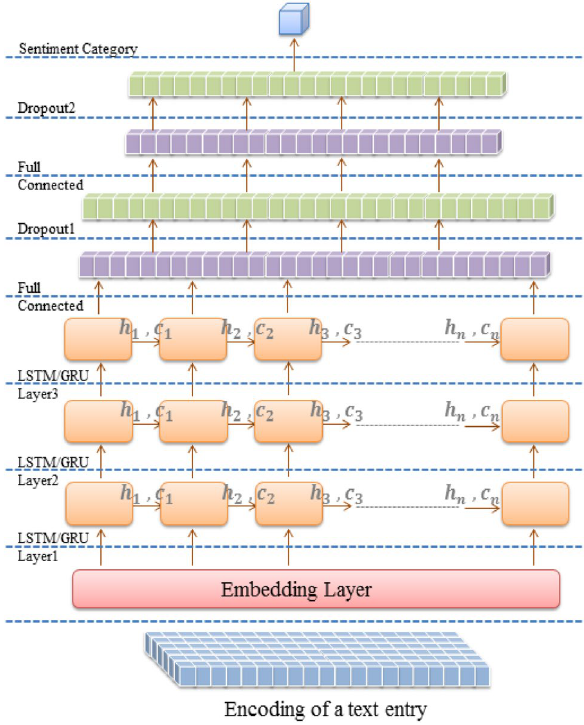
Figure 1. LSTM/GRU architecture (created by Microsoft PowerPoint